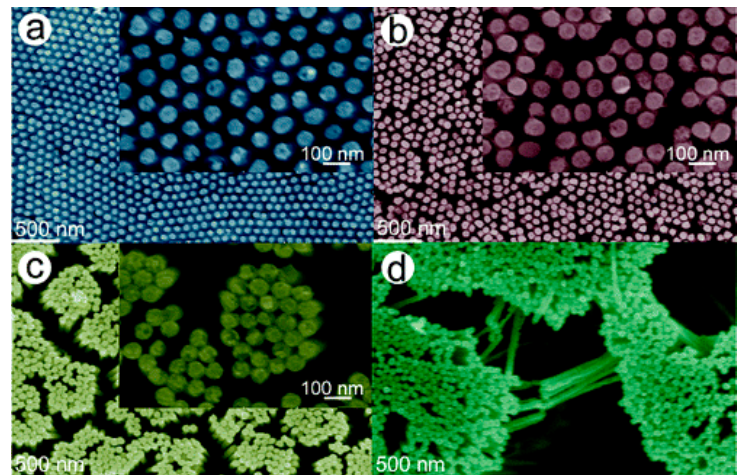
Figure 30. Steps involved in the fabrication of a hexagonal array of metallic nanopillars with the anodic alumina template method. ( a ) An aluminum foil is polished; ( b ) An array of vertically aligned nanopores is produced by anodization; ( c ) Pores can be widened by etching with a phosphoric acid solution in order to tune the wall thickness and hence the gap size in the final structure; ( d ) Silver is electrodeposited in the pores forming nanopillars of controlled hight; ( e ) Alumina is partially etched to expose the silver nanopillars; ( f ) The final array is characterized by interparticle distance S, interparticle gap W and nanopillar diameter D. Reproduced with permission from Wang et al. [402]. Copyright (2006), John Wiley and Sons.